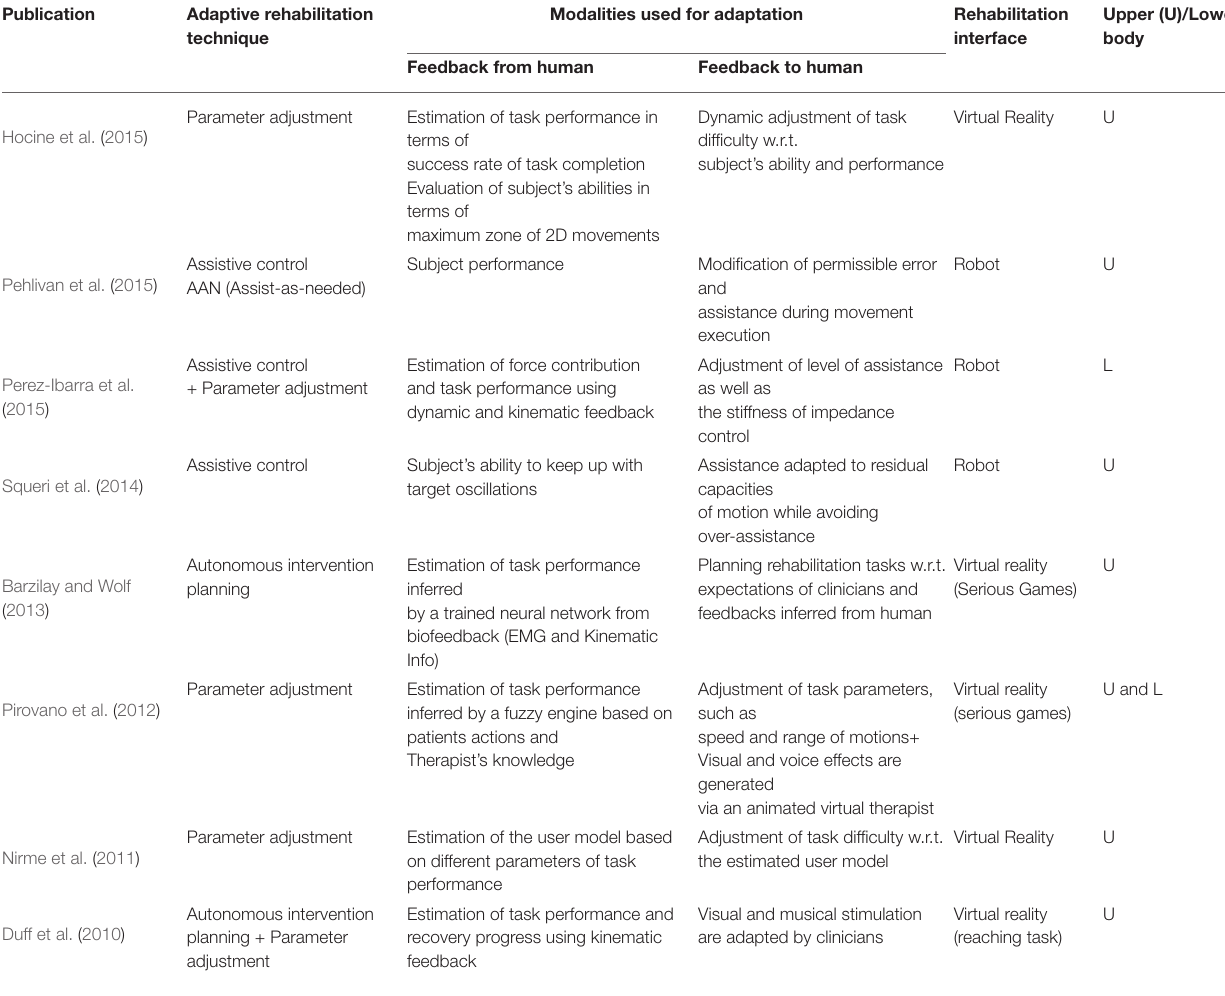
TABLE 1 | Different adaptive rehabilitation approaches using virtual reality (VR) and